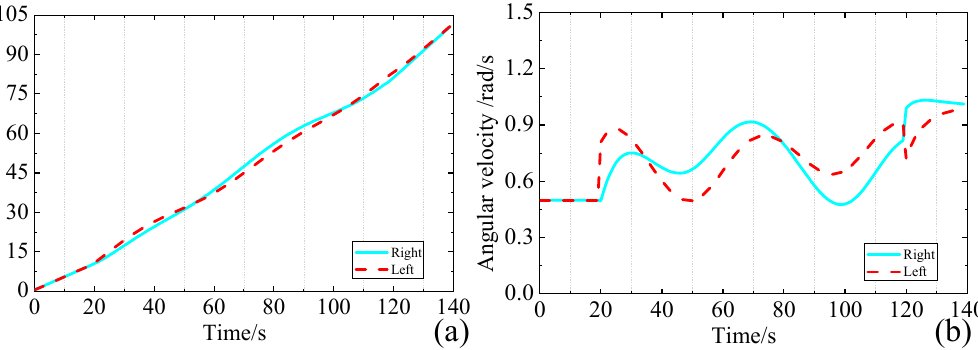
Figure 6. Angle displacement curve ( a ) and angle velocity curve ( b ) of the trajectory-tracking pro- cess.